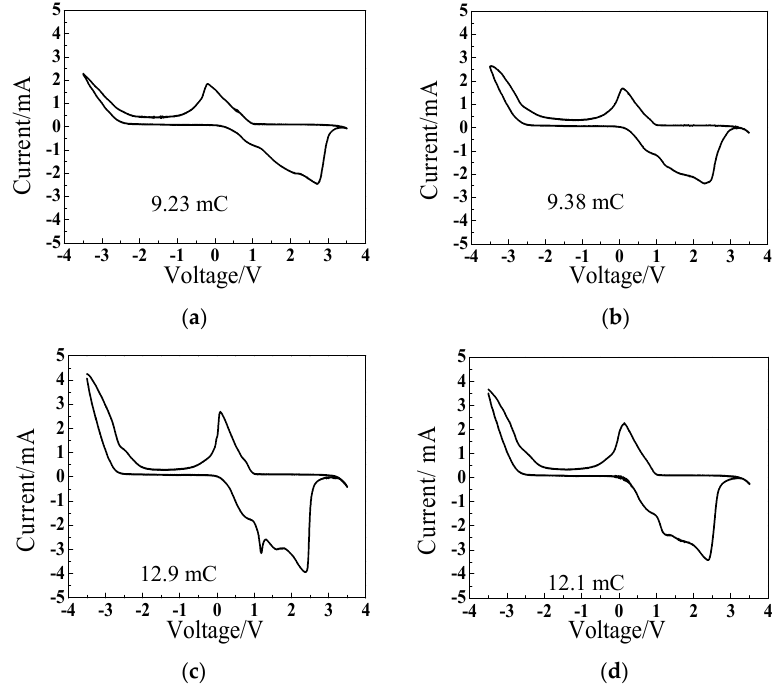
Figure 5. Cyclic voltammetry of electrochromic devices (ECDs): ( a ) WO 3 ; ( b ) LW1; ( c ) LW2; ( d ) LW3.